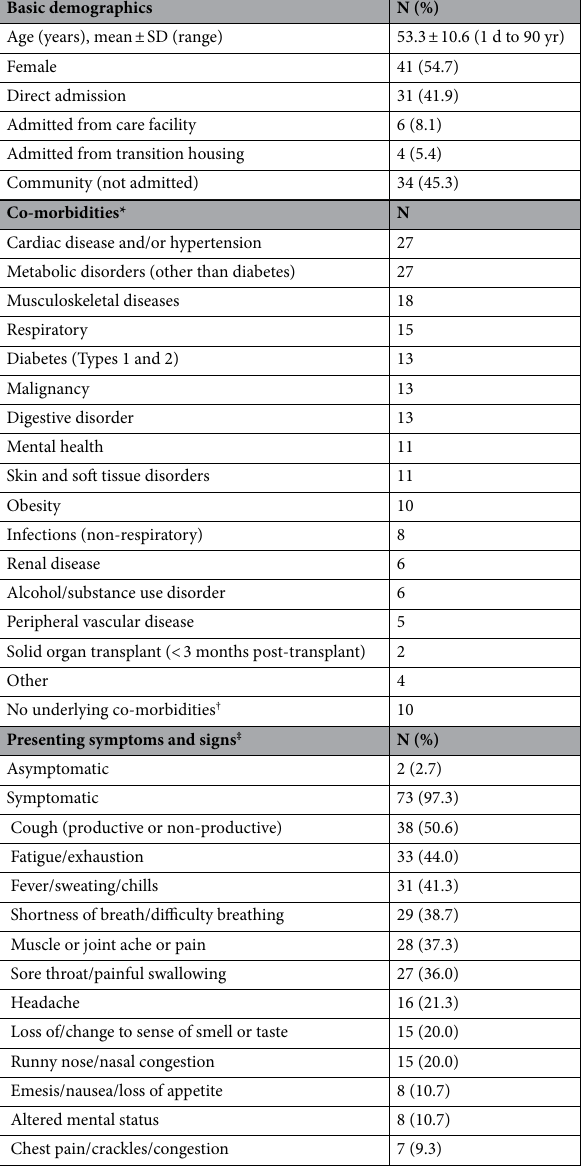
Table 1. Clinical characteristics of COVID-19 cases (n = 75). *Co-morbidities are not mutually exclusive. † Mostly community participants. ‡ All symptoms and signs (mean of 3.5 per